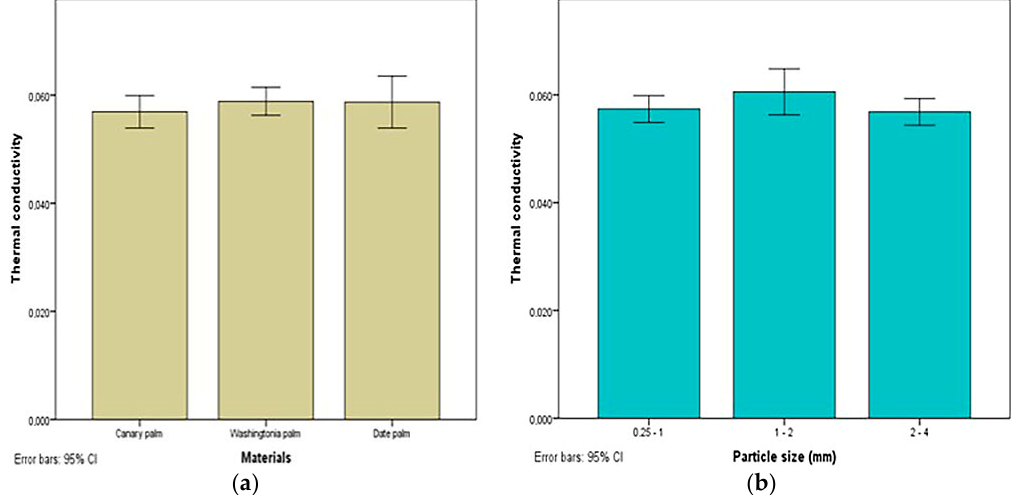
Figure 8. ( a ) Average thermal conductivity results according to the palm species. ( b ) Average thermal conductivity results according to the particle size.